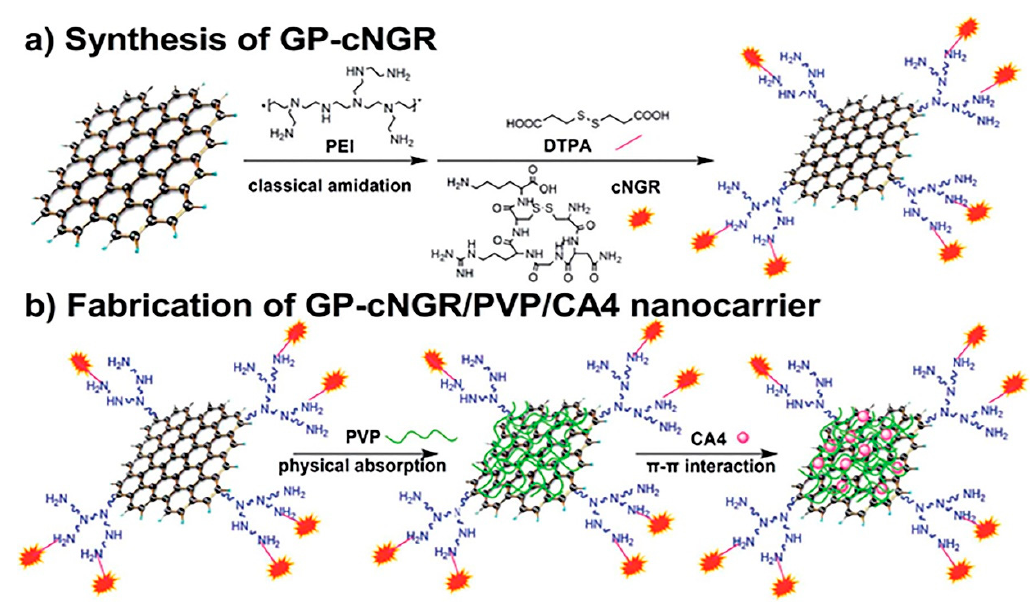
Figure 9. Schematic representation of the synthesis of cyclic aminopeptidase N (APN) ‐ targeting peptide (cNGR) ‐ modified functionalized graphene oxide (GO) nanosheets and preparation of drug delivery system GP–cNGR/polyvinylpyrrolidone (PVP)/Combretastatin A4 (CA4) [165]. Top: scheme ( a ); bottom: scheme ( b ). (Reprinted with permission from Ding et al. ‘A tumor ‐ targeting drug delivery system based on cyclic NGR ‐ modified, combretastatin A4 ‐ loaded, functionalized graphene oxide nanosheets’. RSC Adv. 2016 , 6 , 68134–68140. Copyright (2020) Royal Society of Chemistry).